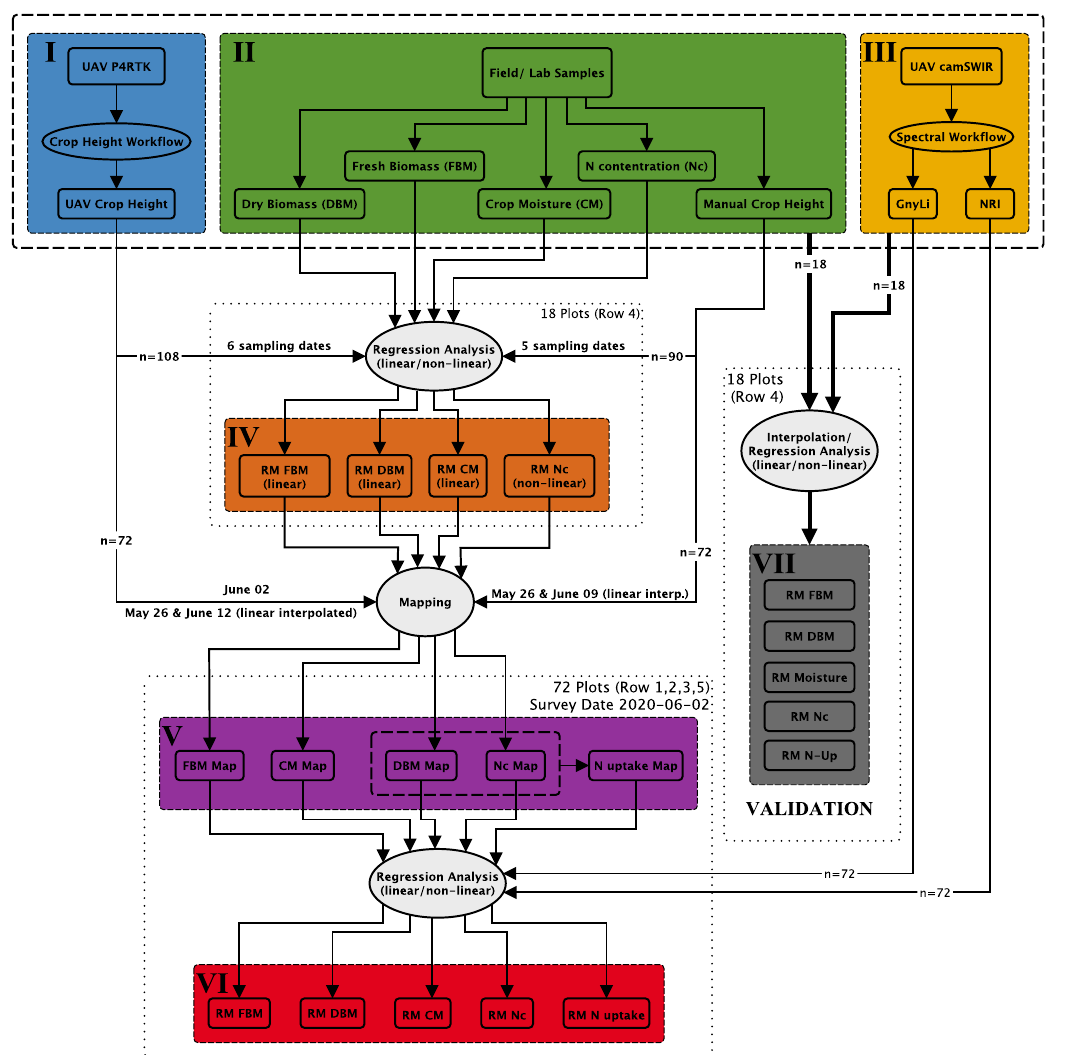
Figure 7. Simplified scheme of the developed crop trait estimation workflow.